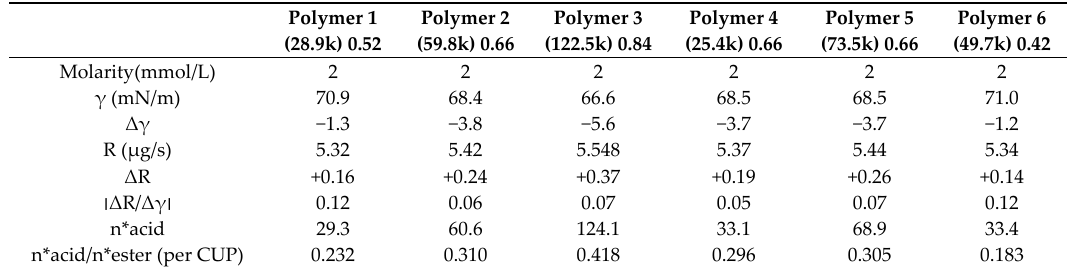
Table 3. Comparison of surface tension and evaporation rate of CUP solutions.